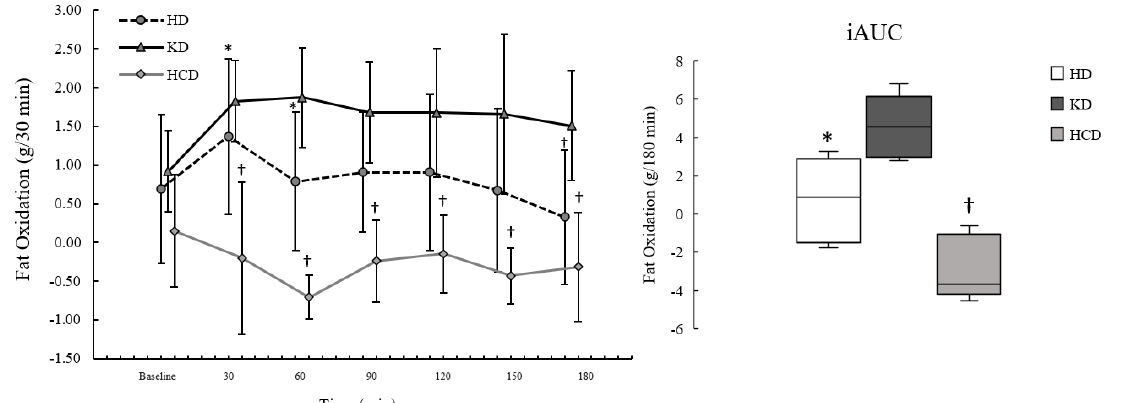
Figure 3. Fat oxidation (FatOx) following a ketogenic meal (KD), a high-carbohydrate meal (HCD), and a habitual meal (HD). Each point on the line graph is plotted as mean and standard deviation. The boxplots represent the incremental area under the curve (iAUC) where the line within each box represents the 50th percentile; the upper and lower limits of each box represent the 25th and 75th percentile; and the upper and lower error bars representing the 10th and 90th percentile. Postpran- dial FatOx was significantly higher at all timepoints for the KD meal compared to the HCD meal (all p < 0.050) but only at 180 min compared to the HD meal ( p = 0.007). In addition, postprandial FatOx was significantly higher during the HD meal at 30 min ( p = 0.044) and 60 min ( p = 0.050) compared to the HCD meal . FatO iAUC was significantly higher following the KD meal compared to the HCD meal ( p = 0.013) and for the HD meal compared to the HCD meal ( p = 0.035). HD: habitual diet meal; KD: ketogenic diet meal; HCD: high- carbohydrate meal. † = significantly different f rom the KD at p ≤ 0.050. * = signifi- cantly different from the HCD at p ≤ 0.050.